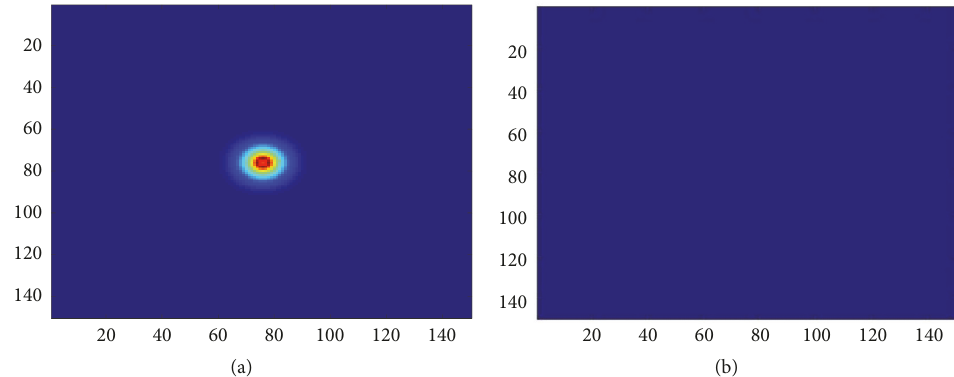
Figure 2: The snapshots of spatial distribution of membrane potential with color scale for neurons in the square array network for 𝑘 = 0 and 𝐷 = 5 at (a) 𝑡 = 2 time units and (b) 𝑡 = 6 time units.